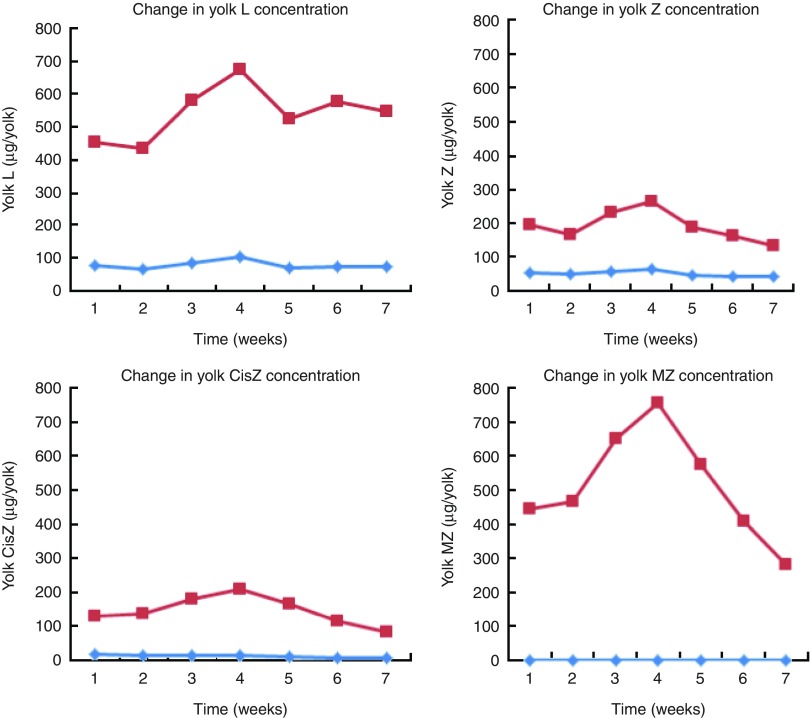
Weekly analysis of egg yolk concentrations (µg/yolk) of lutein (L), total
zeaxanthin (TZ), cis-zeaxanthin (CisZ) and
meso-zeaxanthin (MZ) over a 7-week period using both reversed phase
HPLC for L, TZ and CisZ analysis, and normal phase HPLC for MZ analysis on an
Agilent 1260 Series system (Agilent Technologies Limited) in the Egg Xanthophyll
Intervention Trial. Week-to-week variation can be seen by analysis of the trend in
concentration values of both the control () and enriched
() eggs.